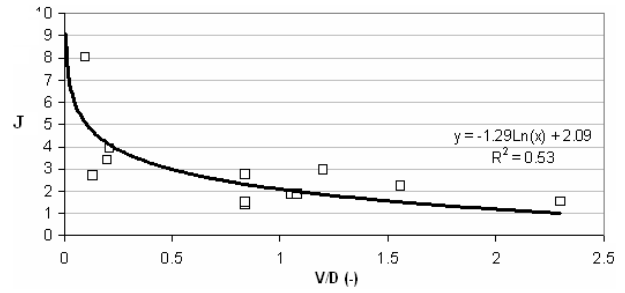
Figure 5. Turbidity potential of accumulated particles (J) in T-piece versus hydraulic conditions.